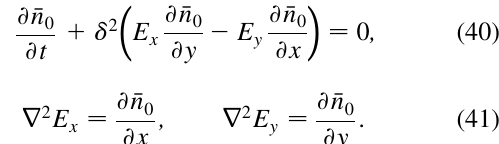
FIG. 3. Velocity field r drically symmetric density distribution. To compare with figures in Refs. [3,18], the beam’s transport direction is along the negative y direction.